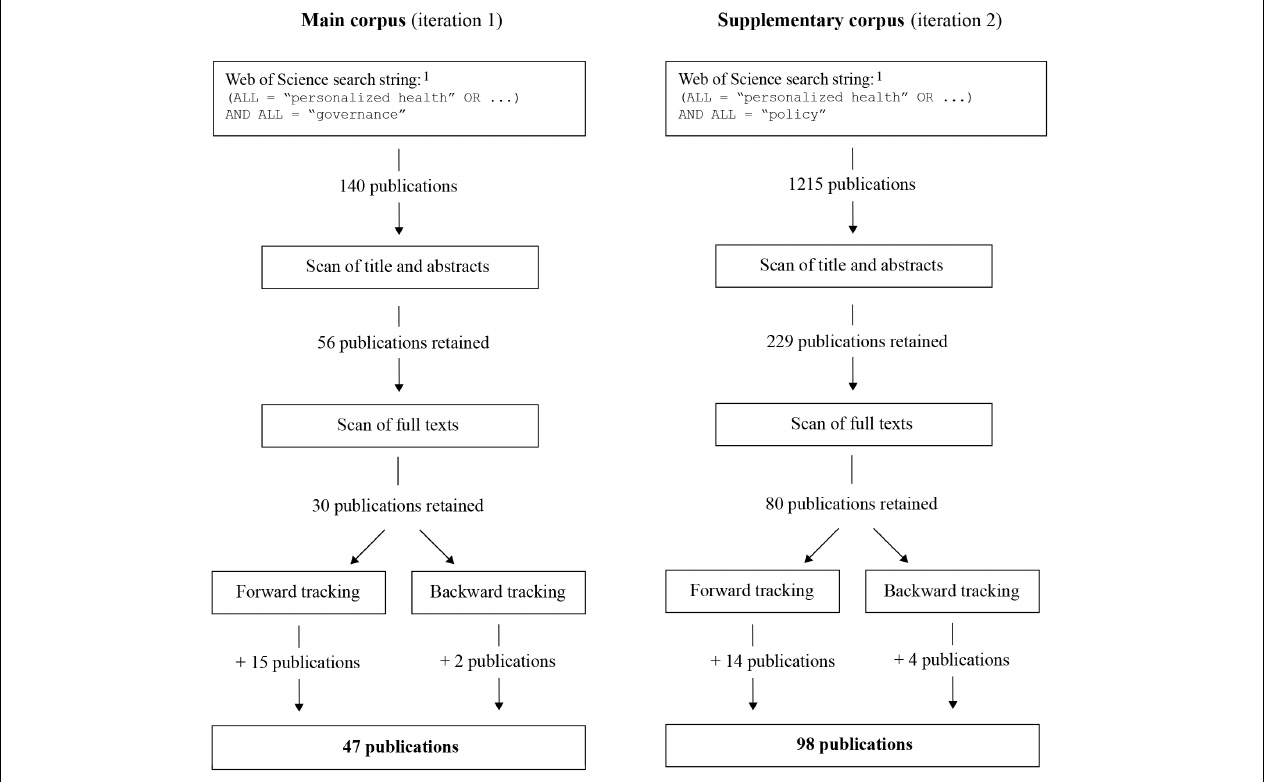
FIGURE 1 | Review